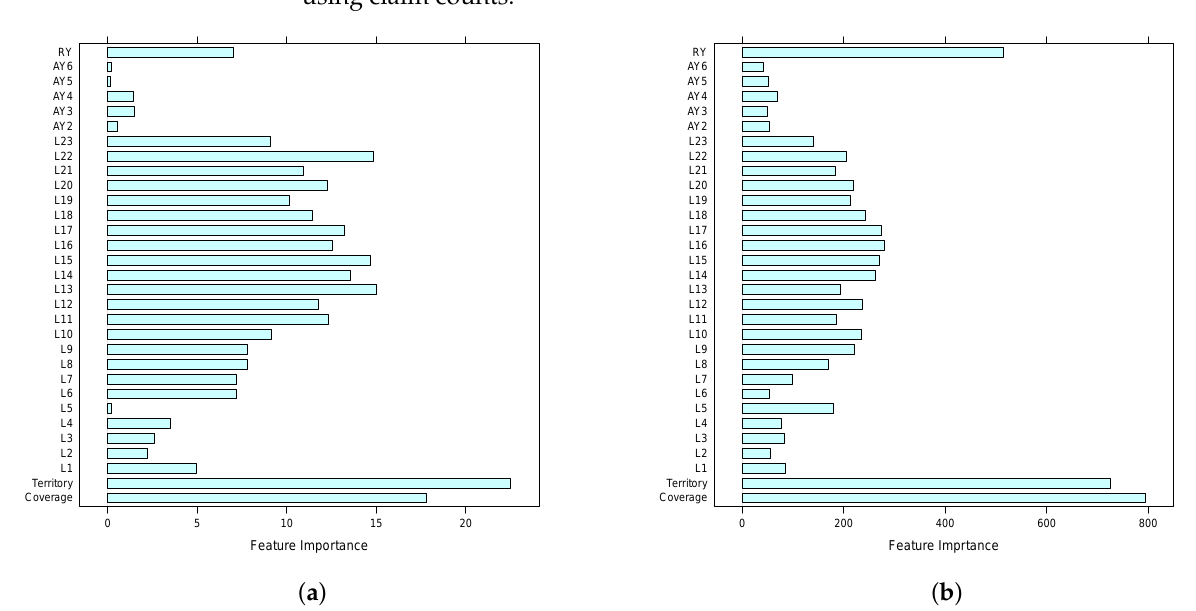
Figure 8. Bar plots for variable importance measure of each factor level in GLM based on the log scale claim amount. ( a ) Gamma as an error function in GLM, where Loss Amounts are used as the response variable. ( b ) Poisson as an error function in GLM, where Claim Counts are used as the response